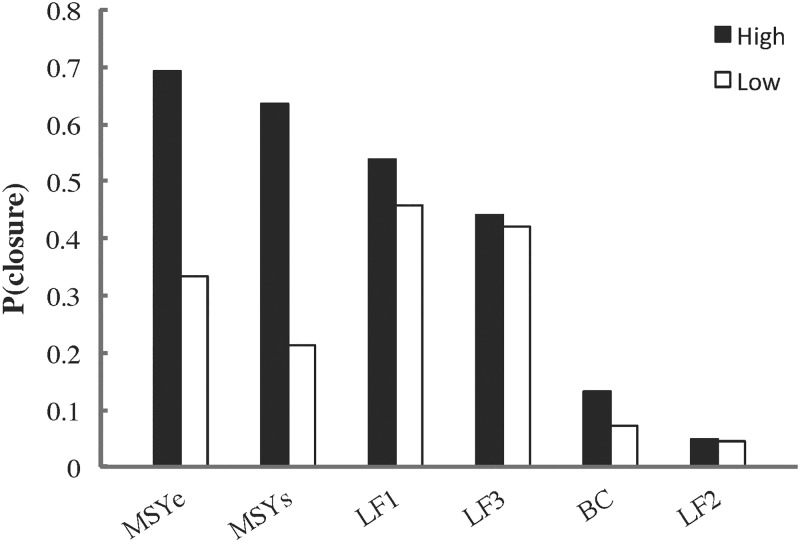
Probability of herring fishery closure by scenario.High and low: Blim for MSY, Ftarget otherwise). For the two constant Ftarget scenarios (SOK and K), the fishery is always open (Blim = 0).